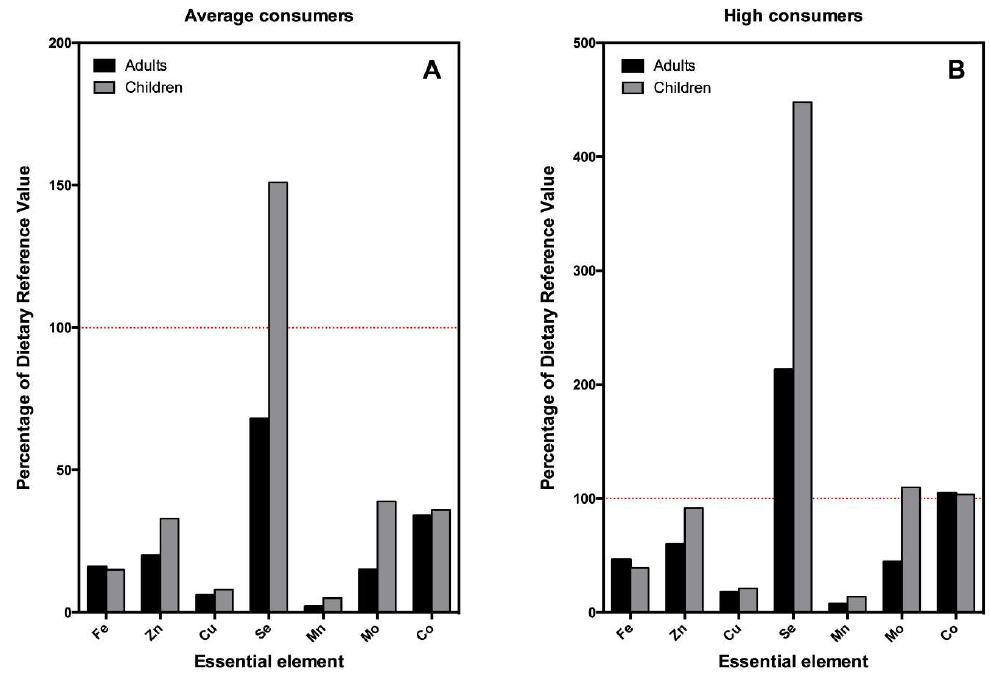
Figure 1. Bar plot indicating the percentage of the dietary reference values (DRVs) of essential elements provided by the consumption of mussels in adults and children. ( A ) Average consumption (percentile 50); ( B ) high consumption (percentile 97.5). Red dotted line indicates 100% of the DRVs of each element. Shaded area between lines indicates.